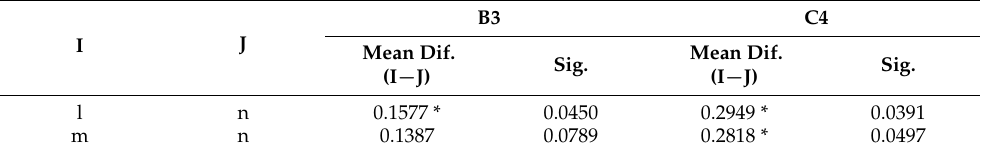
Table 7. Multiple comparison analysis of landscape design indicators of riverside parks in different districts (only some important data are displayed here; all data can be found in the Supplementary